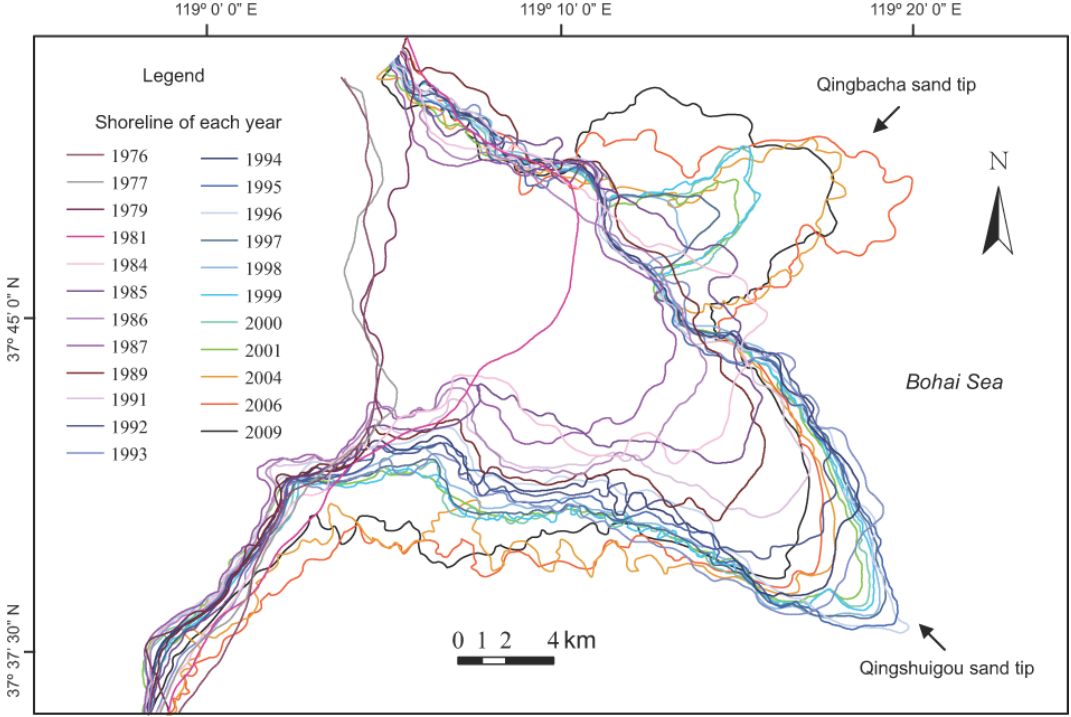
Fig. 4. Evolution processes of the Yellow River Delta from 1976 to 2009.